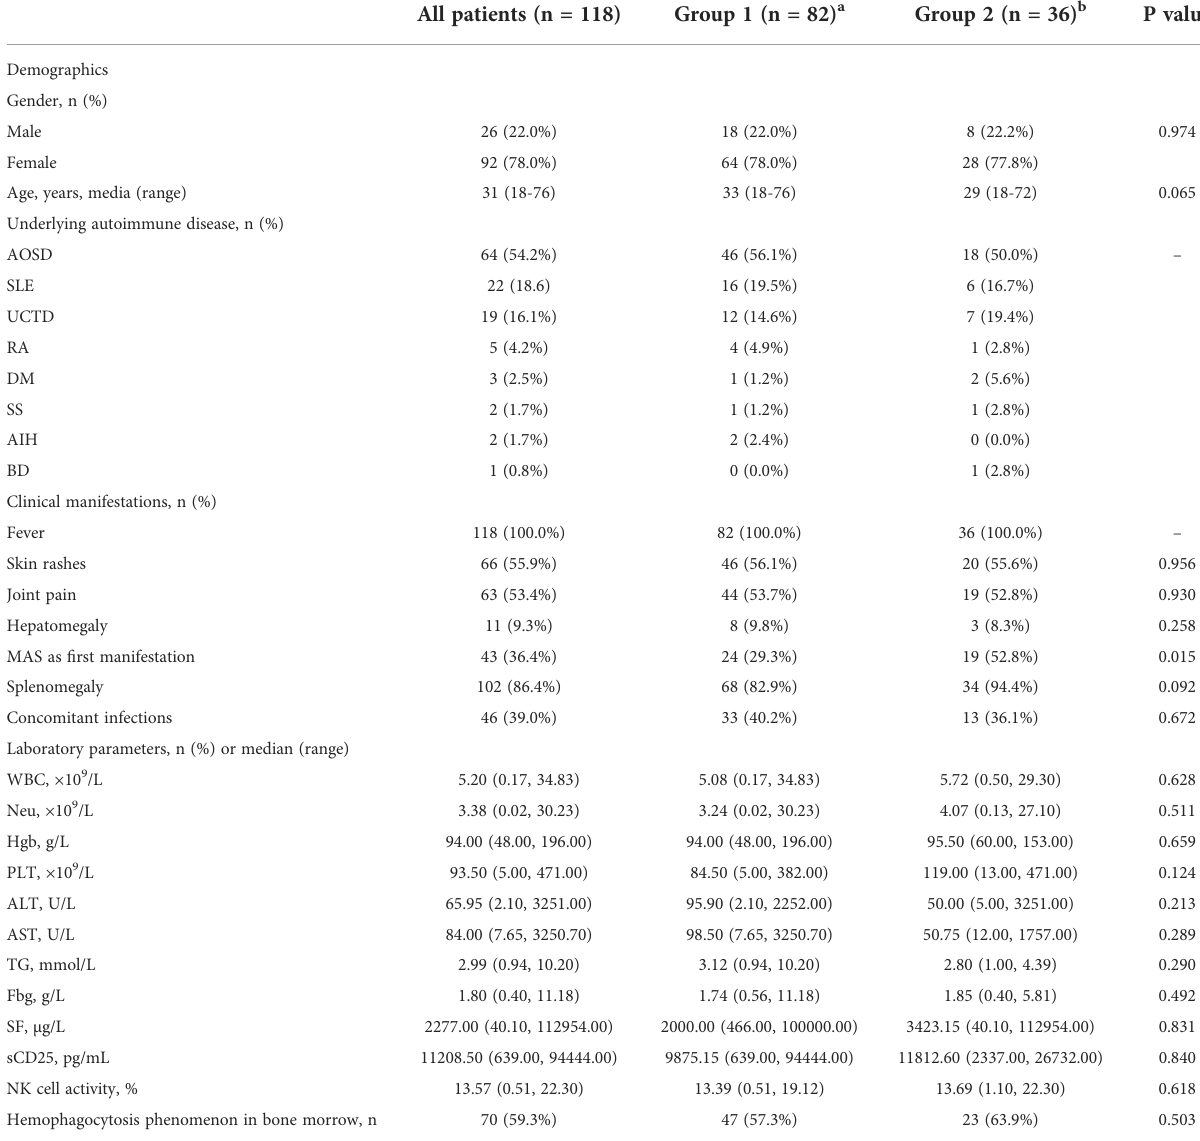
TABLE 1 Baseline demographic characteristics, clinical manifestations, and laboratory features of